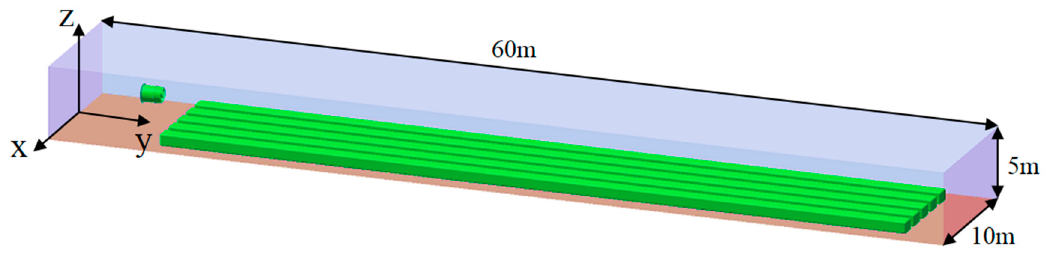
Figure 6. Simulation physical model.